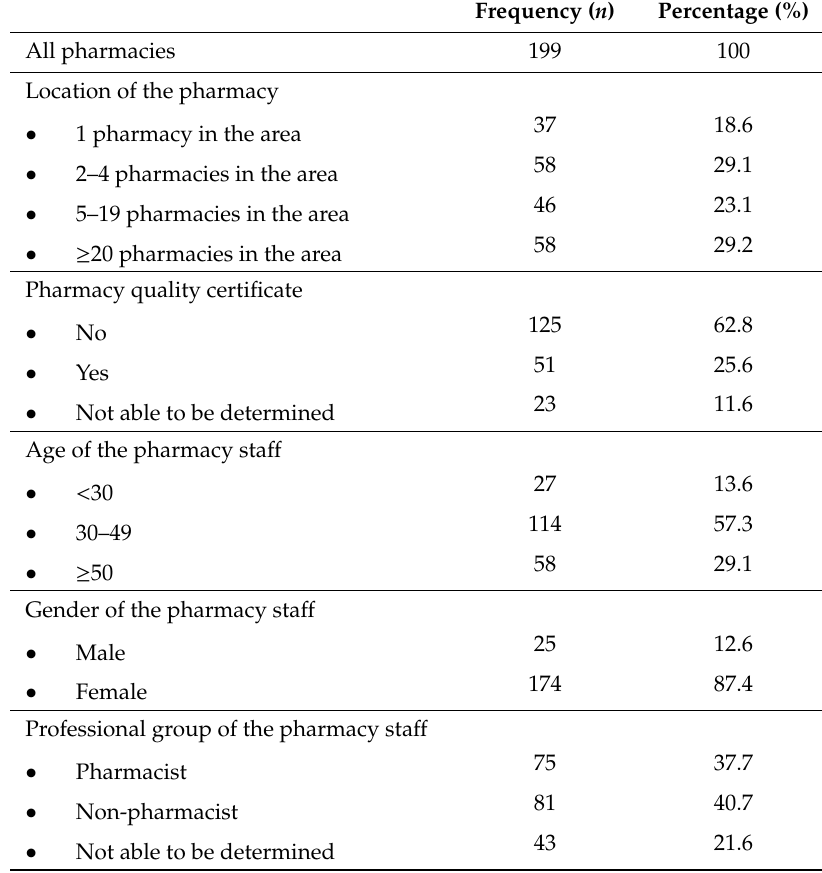
Table 4. Socio-demographic data for the pharmacies or the advising pharmacy sta ff . Frequency ( n ) Percentage